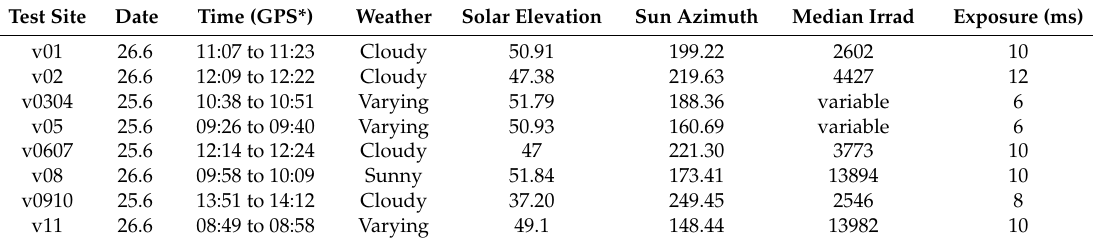
Table 3. Flight conditions and camera settings during the flights. Median irradiance was taken from Intersil ISL29004 irradiance measurements.